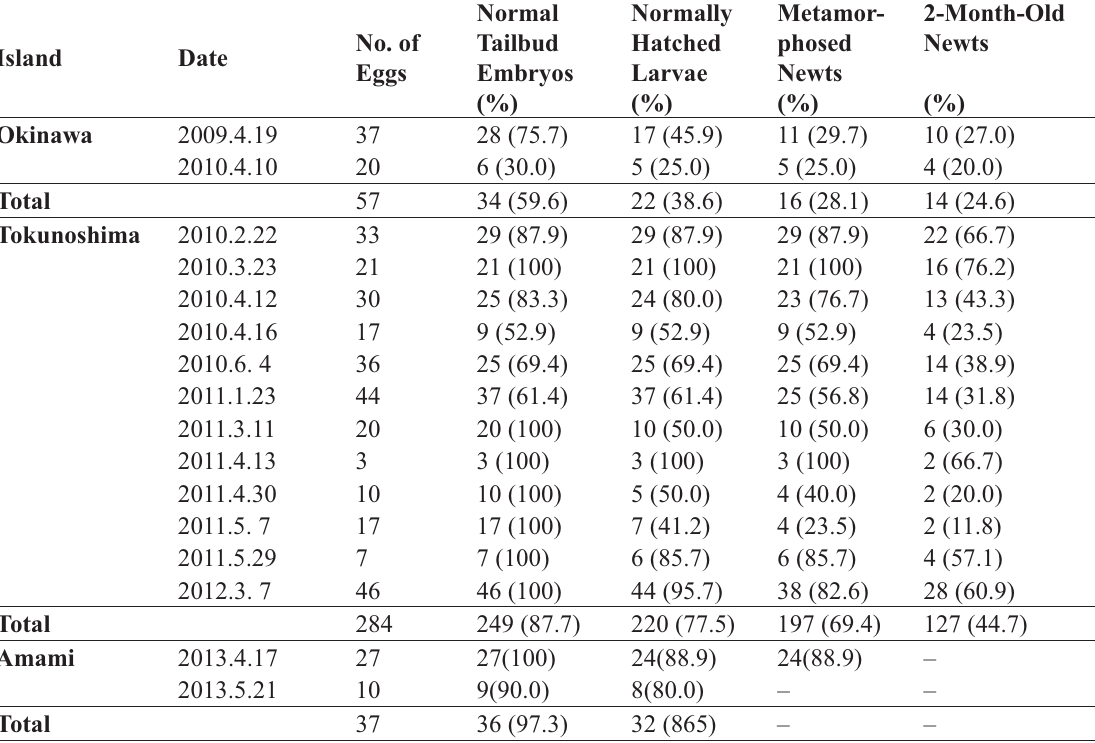
Table 1. Developmental capacity of offspring produced by captive breeding.